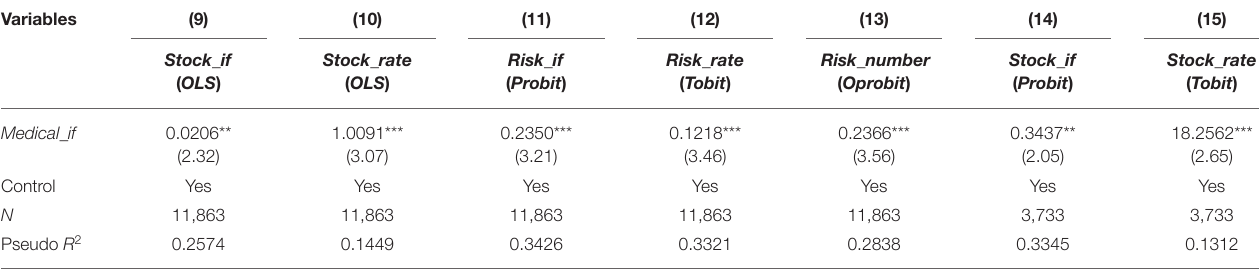
TABLE 6 | Robustness test results.